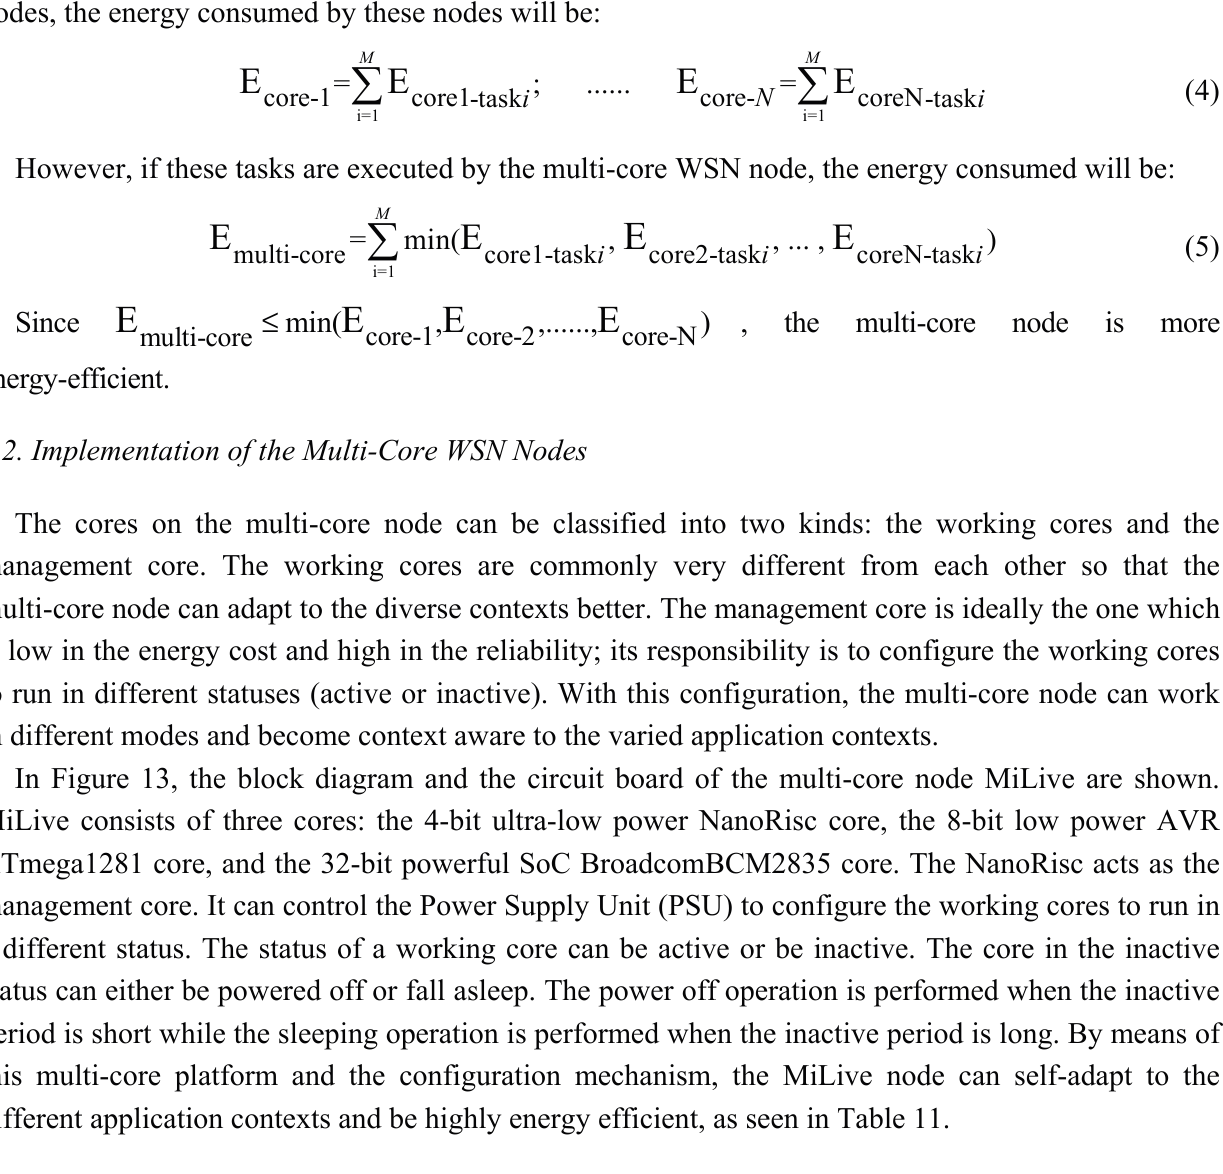
Figure 13. ( a ) Block diagram of the MiLive. ( b ) Prototype board of the